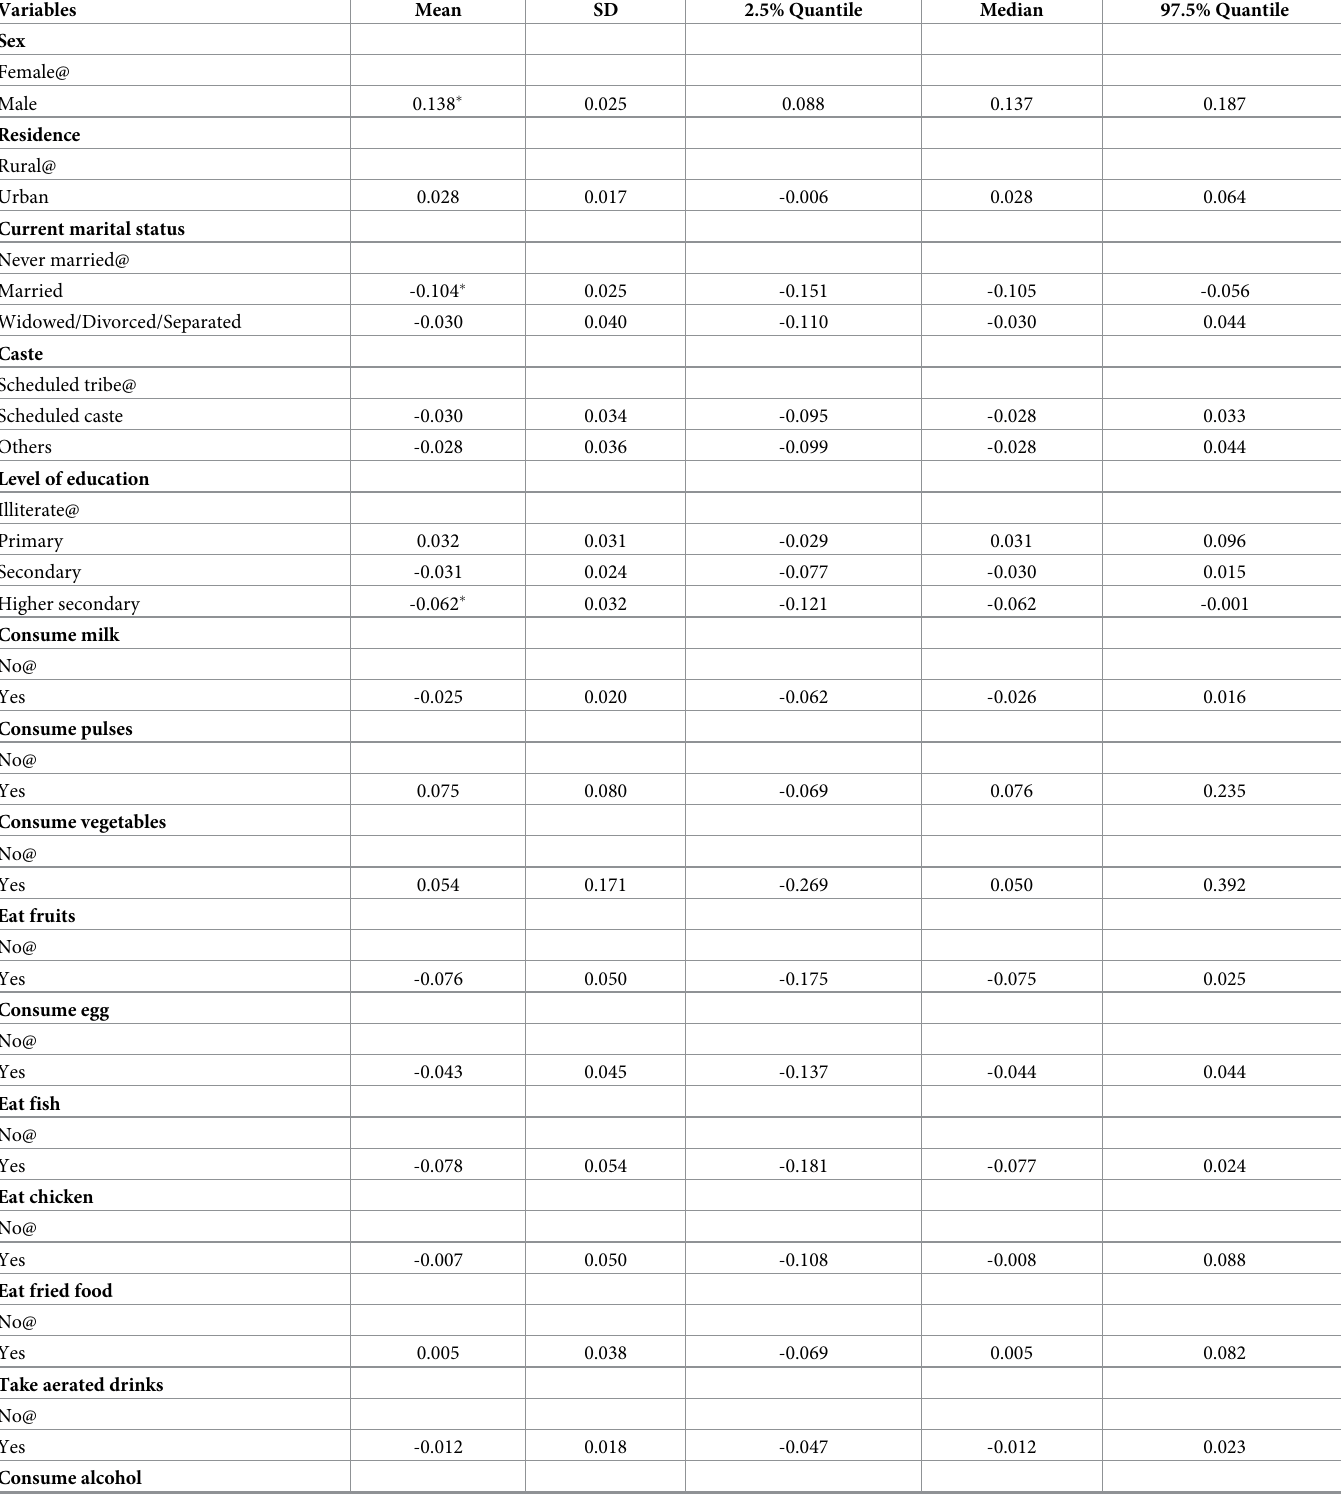
Table 3. Posterior estimates of the fixed effects parameters for diabetes in Northeast